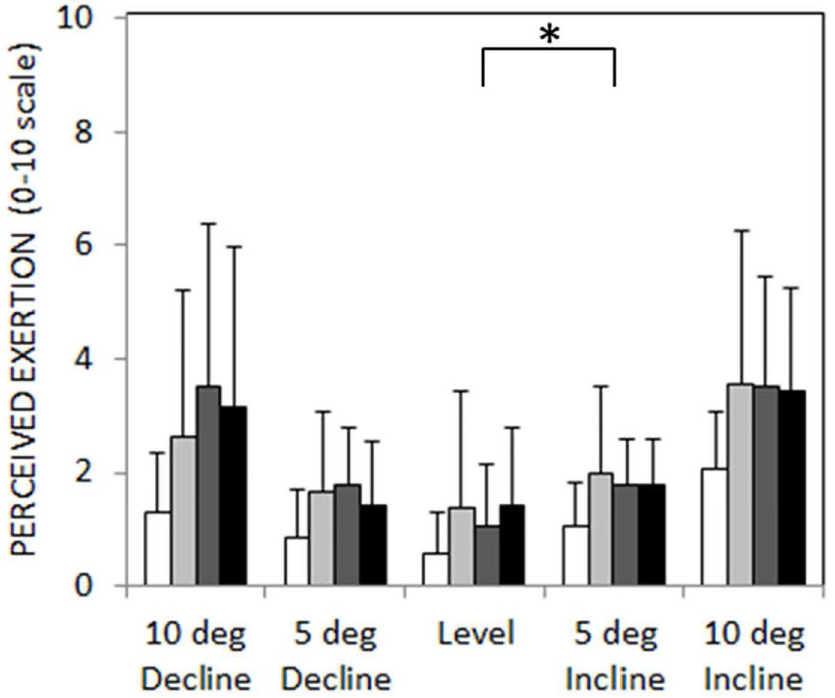
Fig 9. Mean rating of perceived exertion (+ 1 standard deviation) across sloped walking conditions (control = white, RIGID = light gray, MULTI = gray, HYDRA = black). This scale allows subjects to rate their level of effort from 0 (no exertion) to 10 (maximum possibleexertion). An asterisk ( * ) indicatesa statistically significantwithin-groupdifference (p < 0.05)between level and the sloped walkingconditionacross all prosthetic